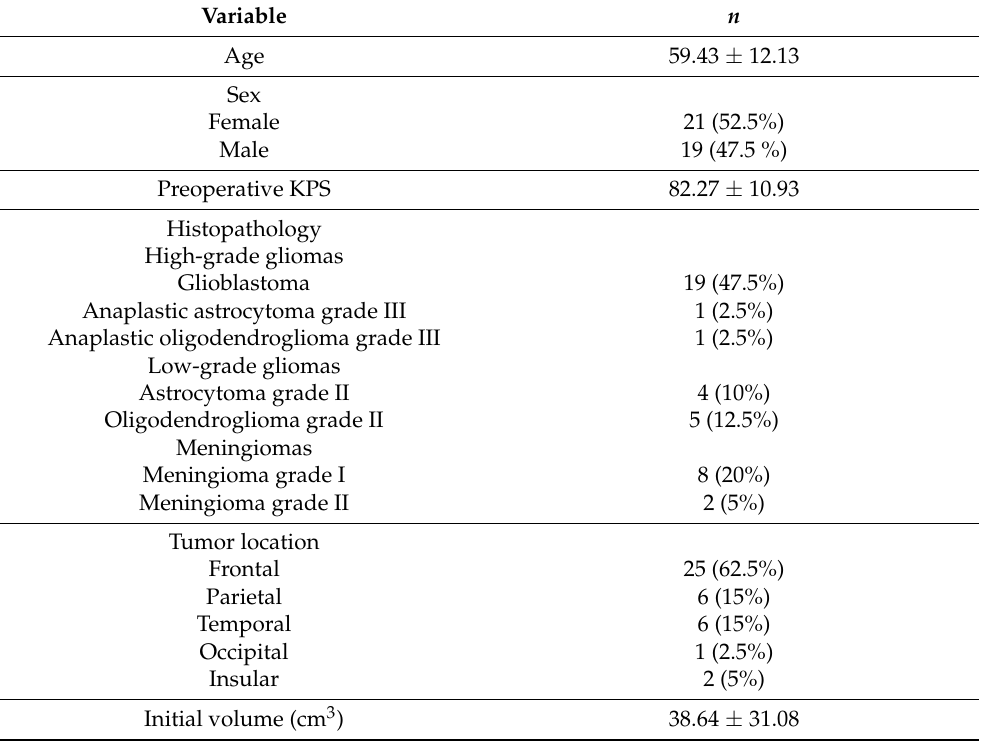
Table 1. Patient